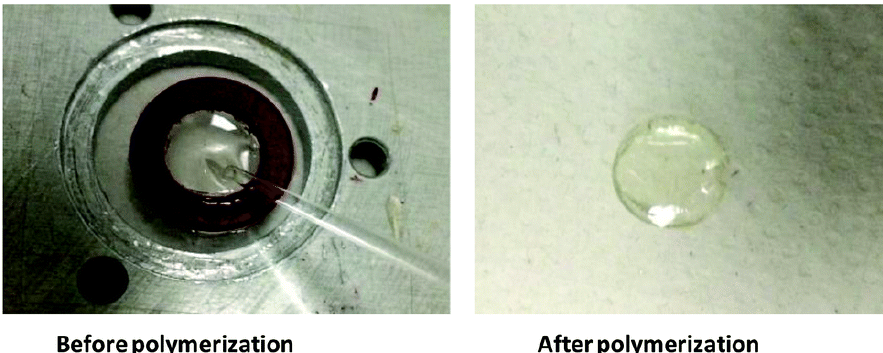
Figure 13. Colorless coatings obtained upon photopolymerization of a BisGMA / TEGDMA (70% / 30% w / w ) blend at 405 nm with the two-component Cu-30 / Iod (0.5% / 1% w / w ) system